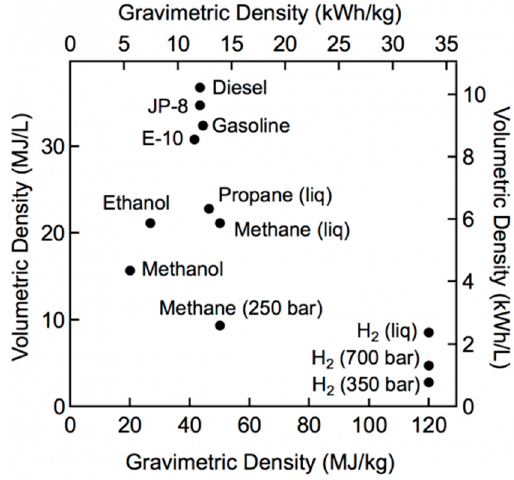
Figure 1. Gravimetric and volumetric density of hydrogen and other fuels [8].